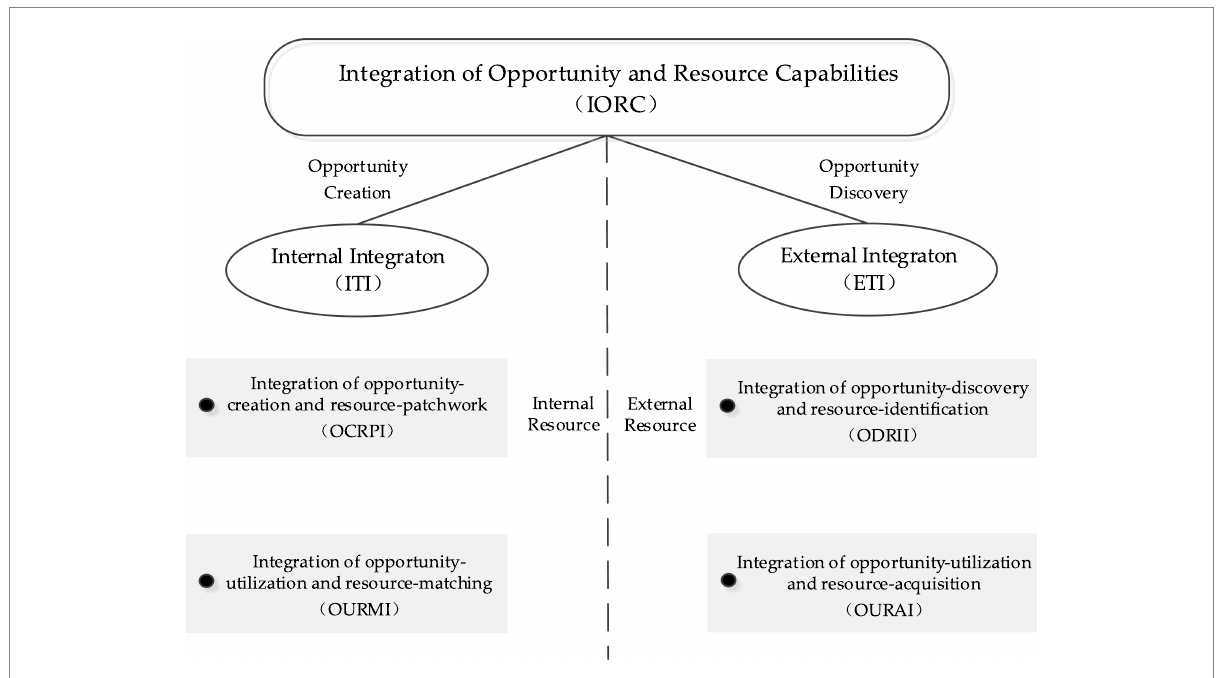
FIGURE 1 The model of the